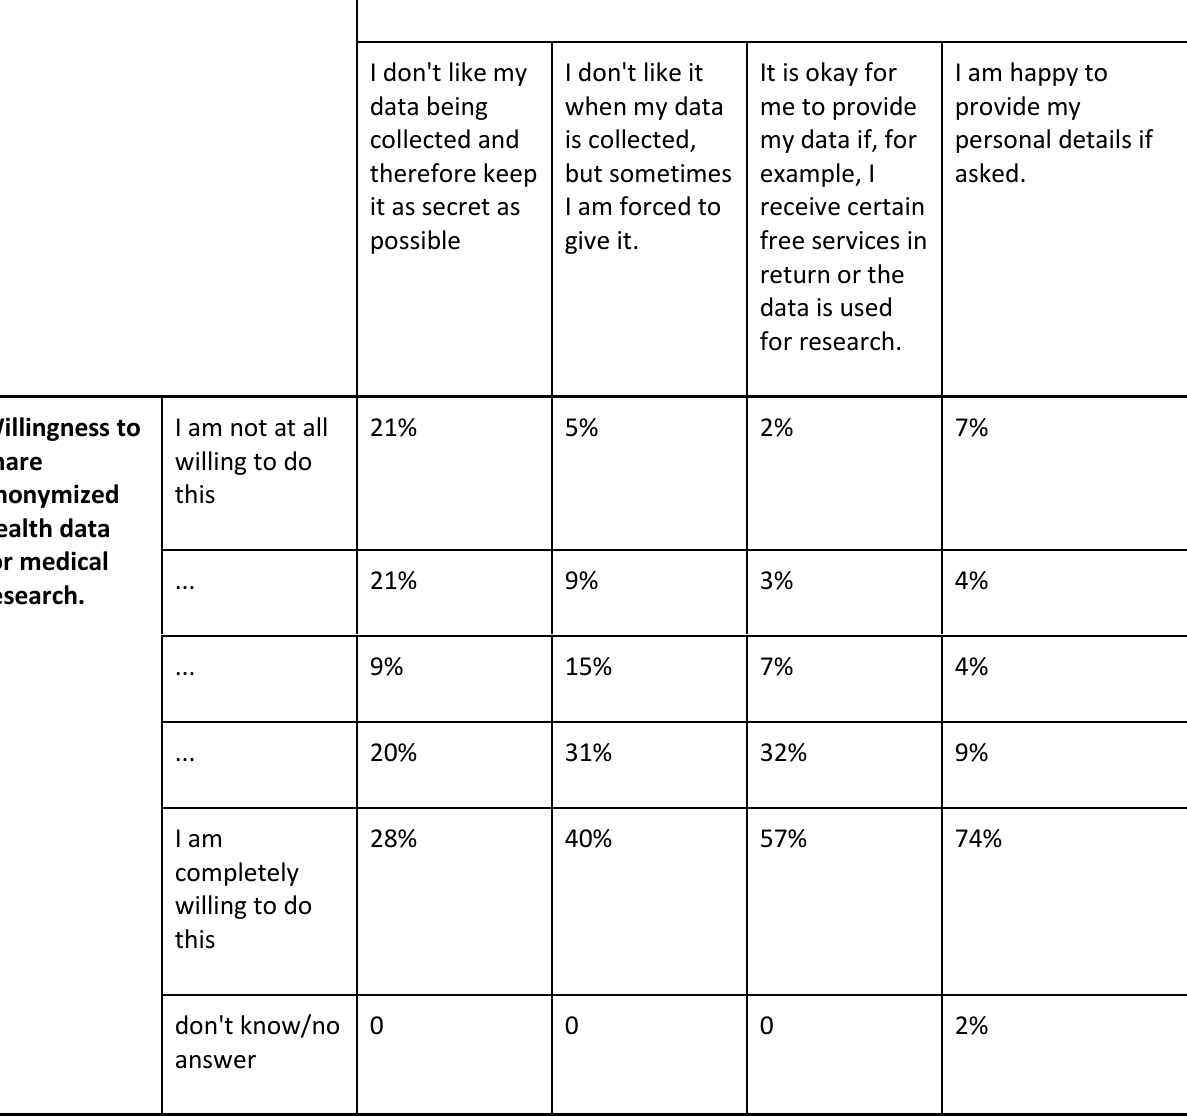
Willingness to share general personal